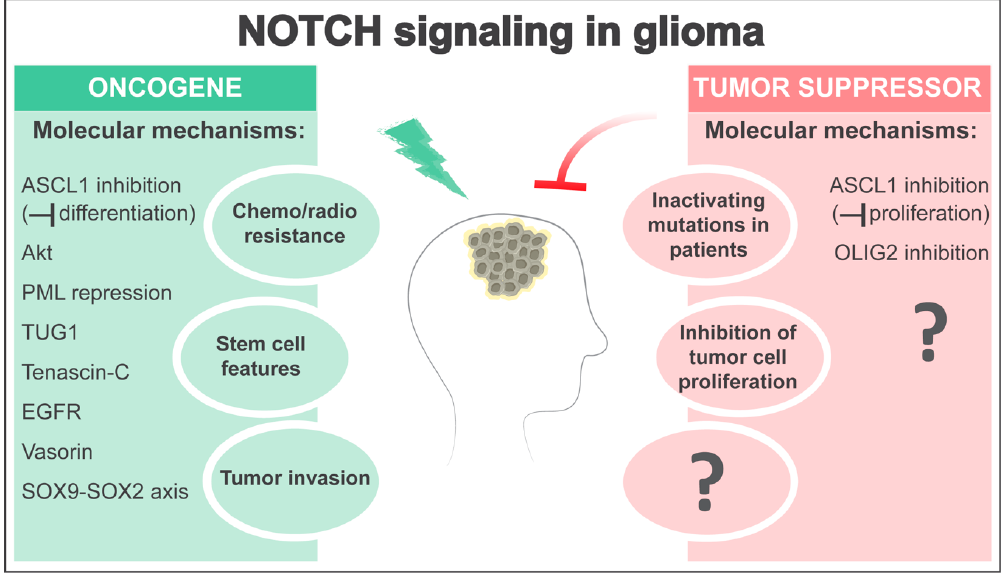
Figure 1. The NOTCH pathway can act either as an oncogene or as a tumor suppressor in glioma, depending on the context. On the one hand, NOTCH signaling activity in subpopulations of glioma cells can enhance stem cell features, promote resistance to radio- and chemo-therapies, and favor tumor development by activating oncogenic pathways (e.g., PI3K/Akt) or inhibiting